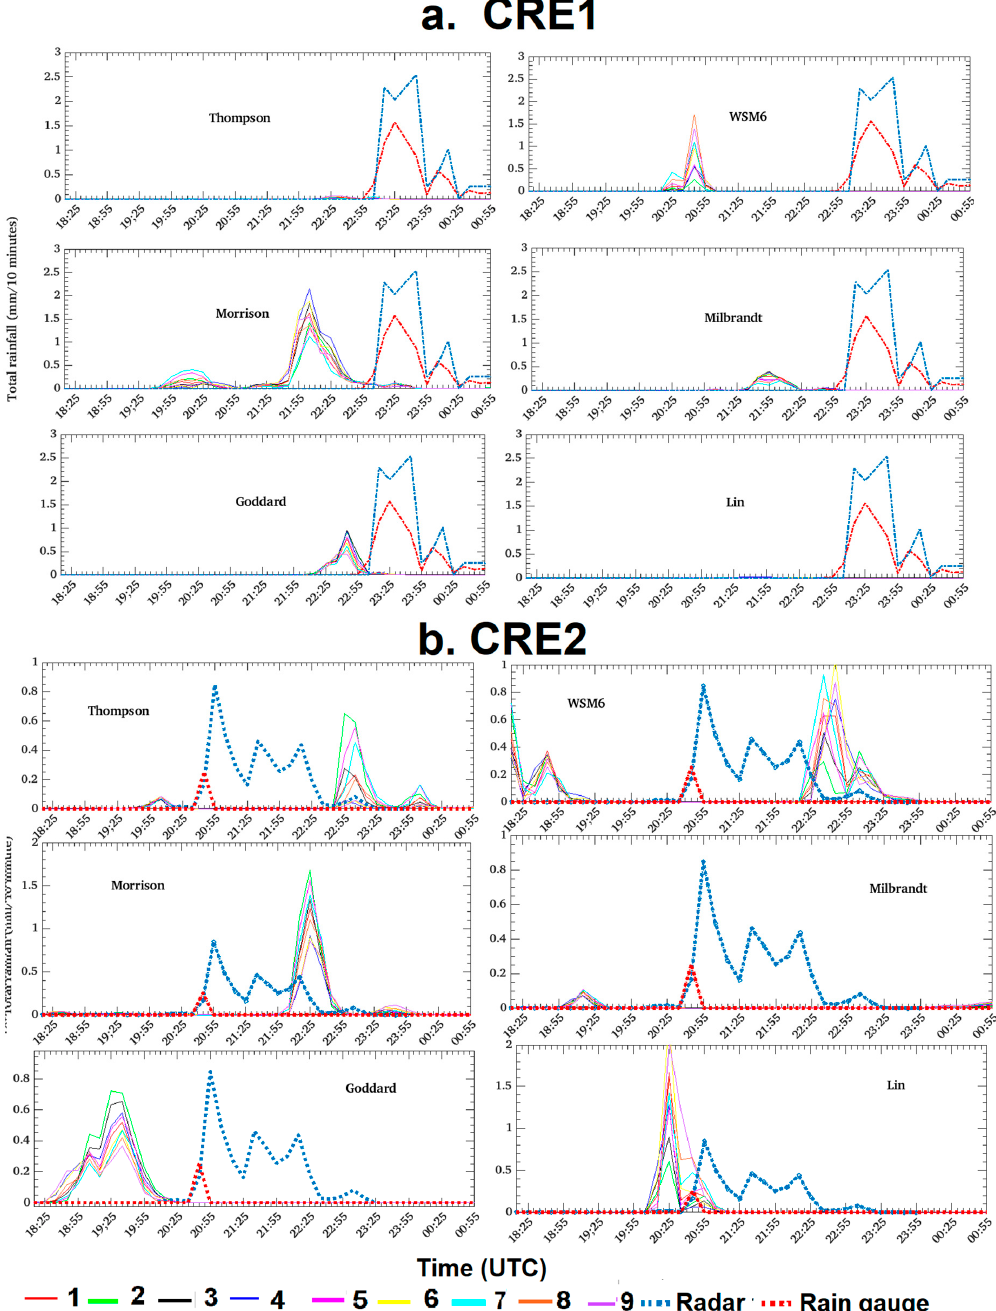
Figure 7. Observed rainfall rate at the HYO surface station and simulated rainfall for an array of nine points in the neighborhood of the station for di ff erent microphysical schemes whose locations are shown in Figure 1b. ( a ). Time series of the Ka band radar estimated rainfall (blue dotted lines), rain gauge observations (red dotted lines) and simulated rainfall (continuous colored lines) for CRE1. ( b ). Same as a, for